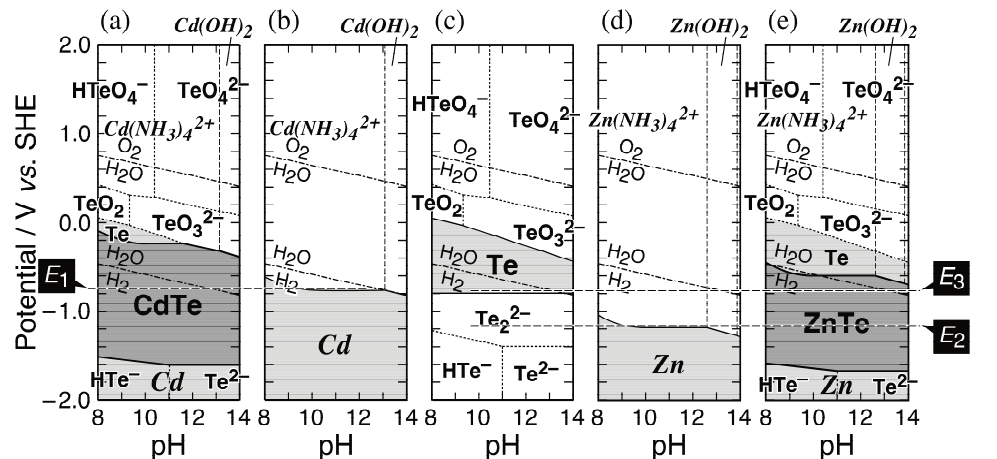
Figure 2. Potential-pH diagrams of (a) Cd-Te-NH 3 -H 2 O, (b) Cd-NH 3 -H 2 O, (c) Te-H 2 O, (d) Zn-NH 3 -H 2 O, and (e) Zn- Te-NH 3 -H 2 O systems at 298 K calculated assuming that the concentration of dissolved cadmium, tellurium, and zinc species is 0.01 M and that the total ammonia concentration, [NH 3 ] total D [NH 3 ] C [NH C window of water was indicated by dot-dashed lines. As for E 1 , E 2 , and E 3 see the